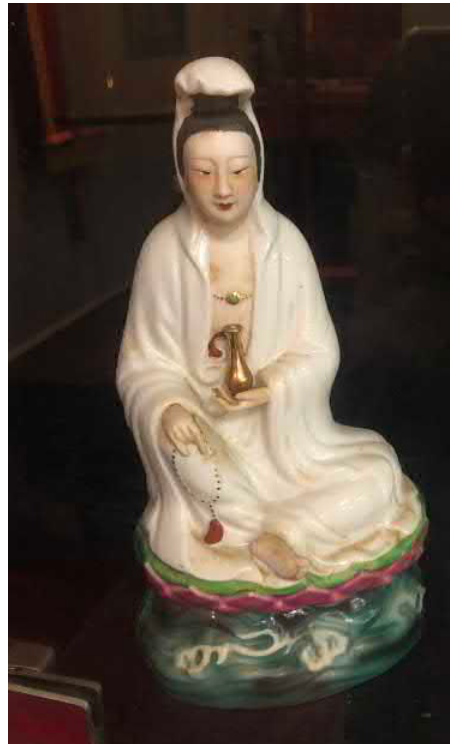
Figure 4: Kuan Yin statue, NT Chinese Temple and Museum, Darwin. (Photo: Anna Halafoff)